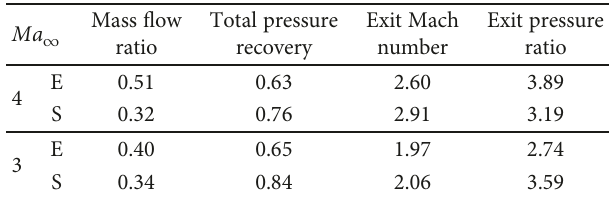
Table 3: Mass-averaged performance of the dual-duct inlet at Ma = 4 and ∞